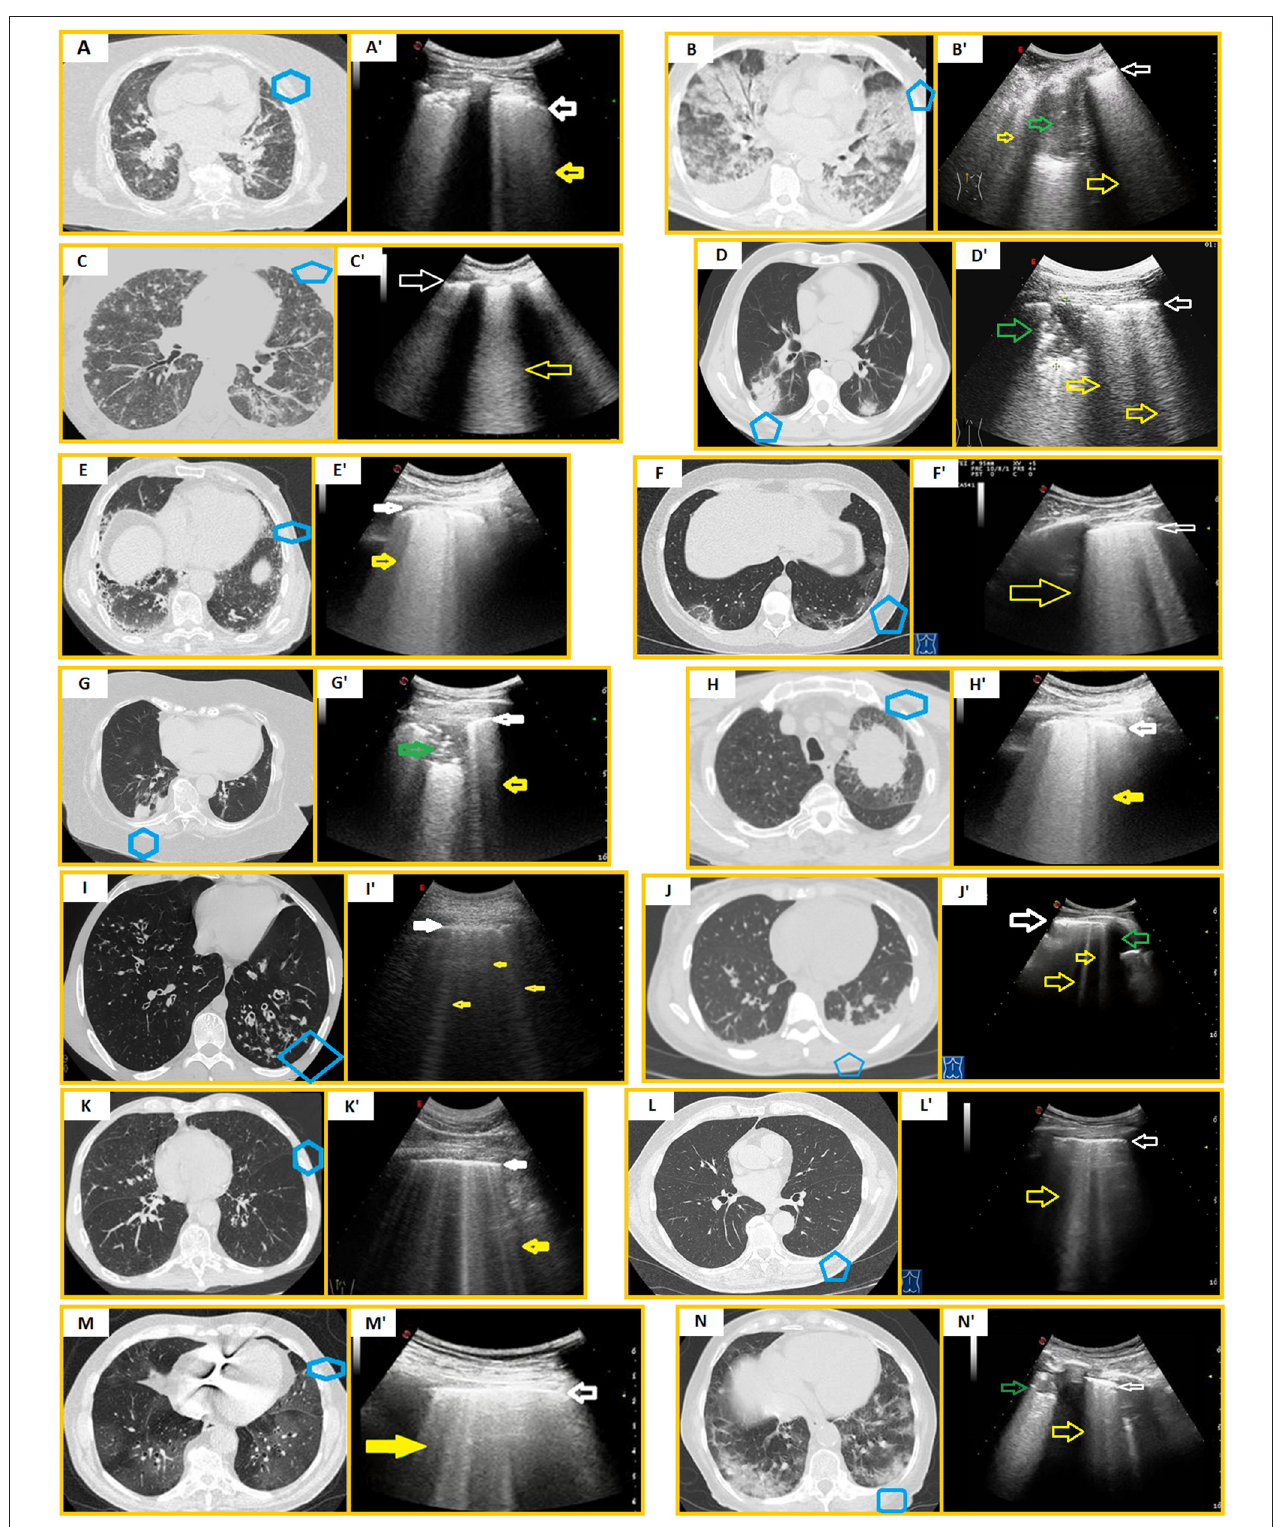
FIGURE 2 | Mimickers of COVID-19 pneumonia vs. COVID-19 pneumonia. Blue boxes in CT scans indicate the corresponding US scans. (A) Axial chest HRCT of a CPE. (A’) US scan with a convex probe (6 MHz) shows a blurred and thickened hyperechoic pleural line (white arrow) followed by focal and coalescent B-lines